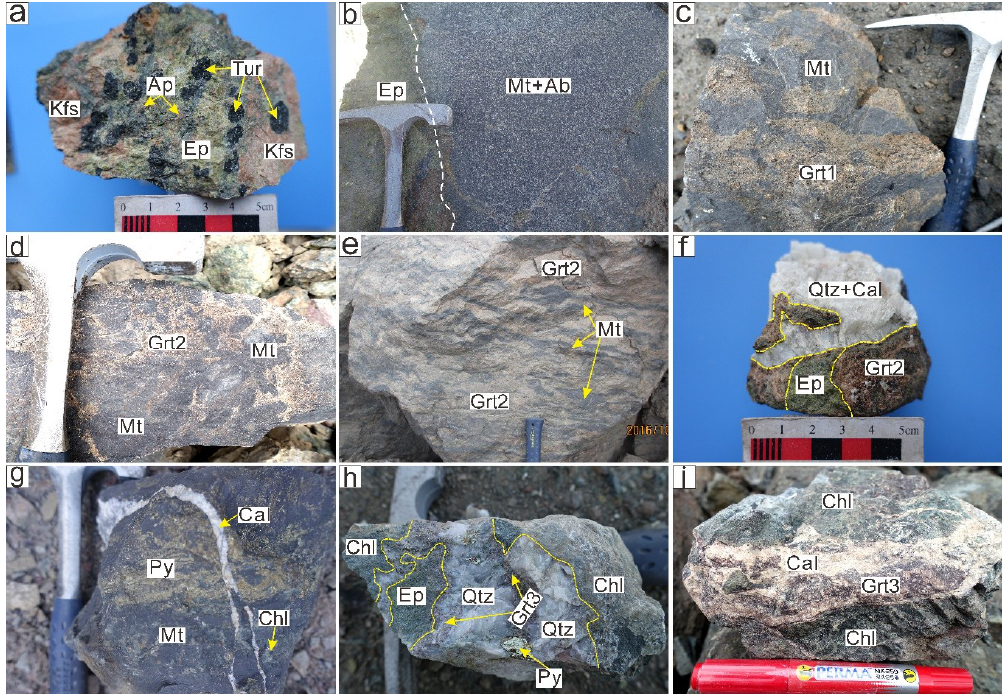
Figure 4. Photographs of representative samples and their relationships in the Yamansu deposit. ( a ) Granular tourmaline and apatite (fine-grained) replaced by epidote and K-feldspar; ( b ) Disseminated magnetite and albite replaced by epidote; ( c ) Massive garnet aggregates (brown or chocolate-brown, coarse-grained) cut by magnetite veins; ( d , e ) An intergrowth relationship with breccia and banded magnetite; ( f ) Garnet (Grt2) skarn cut by epidote vein and followed by quartz + calcite vein; ( g ) Massive magnetite + chlorite ore replaced by pyrite, and both magnetite and pyrite cut by calcite vein; ( h ) Chlorite + epidote skarn cut by quartz + pyrite vein (together with granular Grt3); ( i ) Chlorite skarn cut by